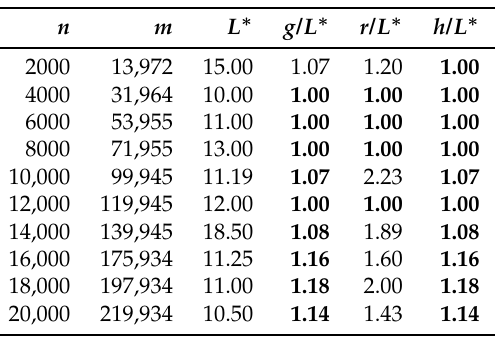
Table 5. Results for k-Trees where k = (cid:98) n 0.25 (cid:99) .